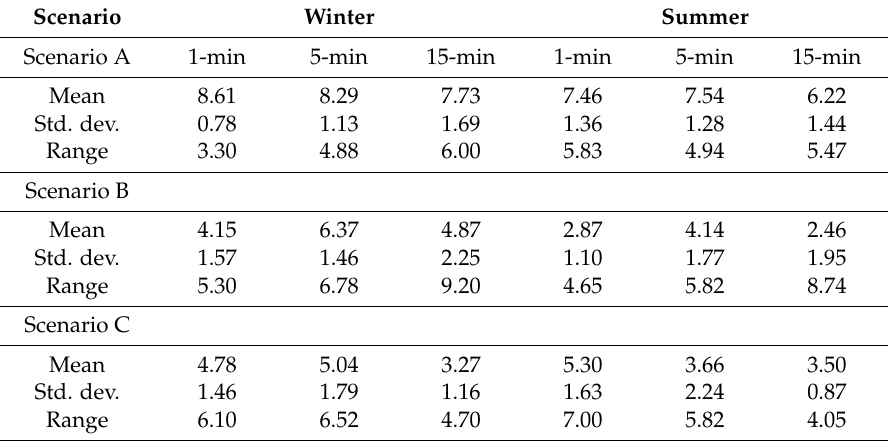
Table 2. Descriptive statistics of observed wind speed distribution (units in